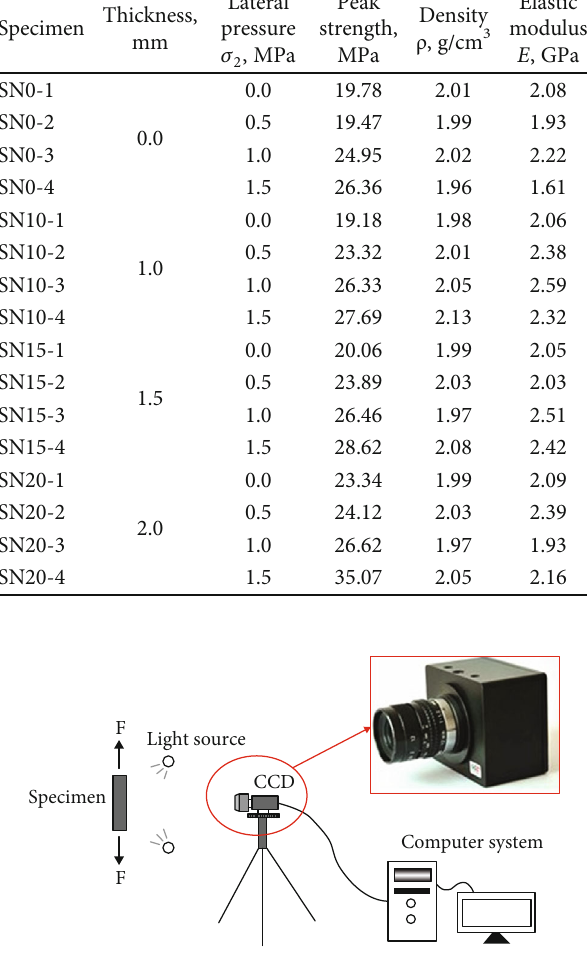
Figure 2: HD industrial camera and strain gauge arrangement